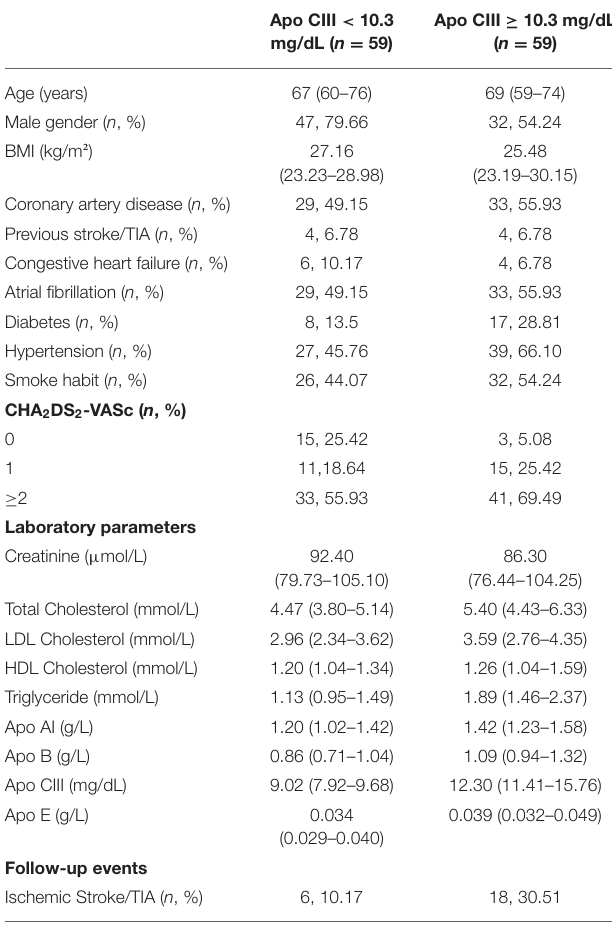
TABLE 2 | Clinical and laboratory characteristics of the study sample at time of enrollment subdivided according to Apo CIII plasma concentration with the median value (10.3 mg/dL) as threshold